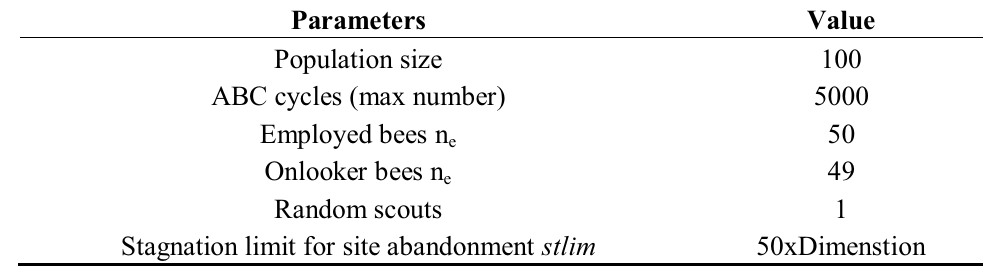
Table 7. The test parameters for the Artificial Bee Colony (ABC) [38].